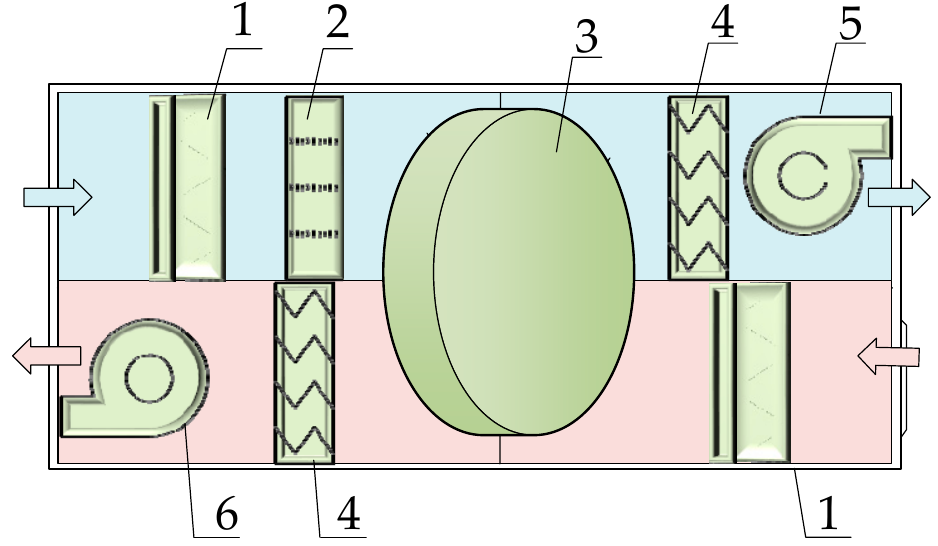
Figure 9. Schematic diagram of heat recovery ventilation system: (1) primary air filter; (2) high e ffi ciency air filter; (3) rotary heat exchanger; (4) electrostatic precipitator; (5) air blower; (6) exhaust fan.